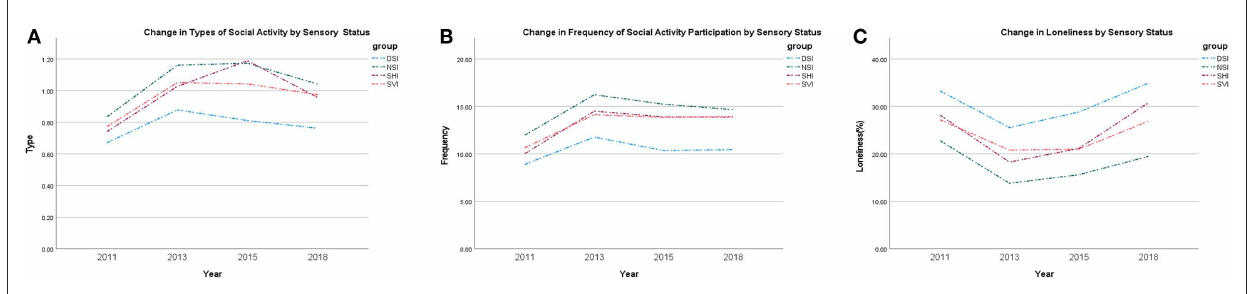
FIGURE2 Changes of social disconnectedness and loneliness over time, 2011–2018. NSI, No sensory impairment; SVI, Single vision impairment; SHI, Single hearing impairment; DSI, Dual sensory impairments.